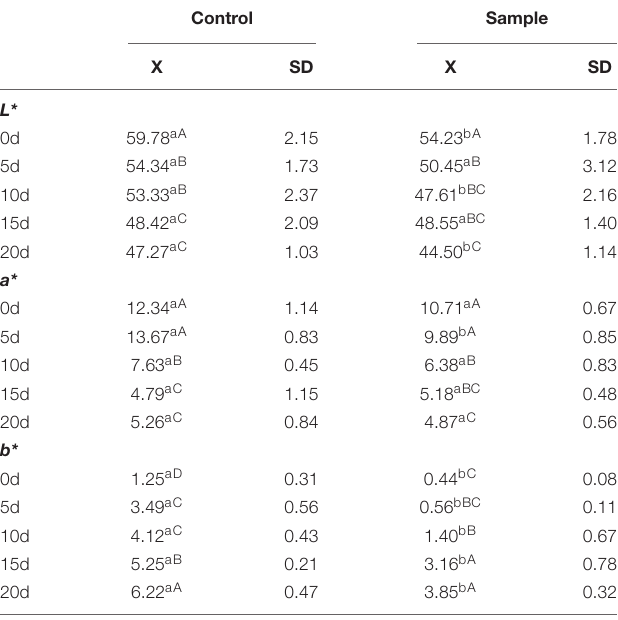
TABLE 1 | The color of the sausages during ripening